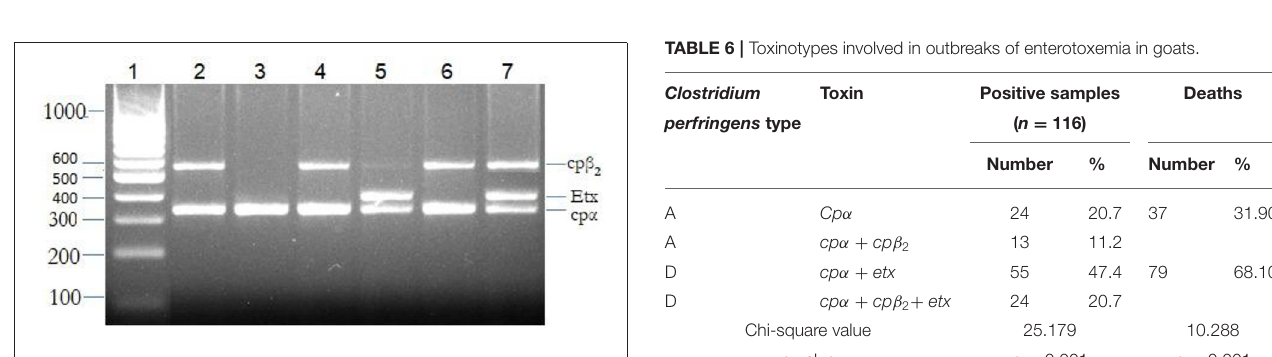
FIGURE 4 | The multiplex polymerase chain reaction (PCR) for the detection of toxinotypes released by Clostridium perfringens . Bands 1: molecular marker; 2, 4, and 6: cp α + cp β 2 ( C. perfringens type A), 3: cp α ( C. perfringens type A), 5: cp α + etx ( C. perfringens type D), and 7: cp α + cp β 2 + etx ( C. perfringens type D).